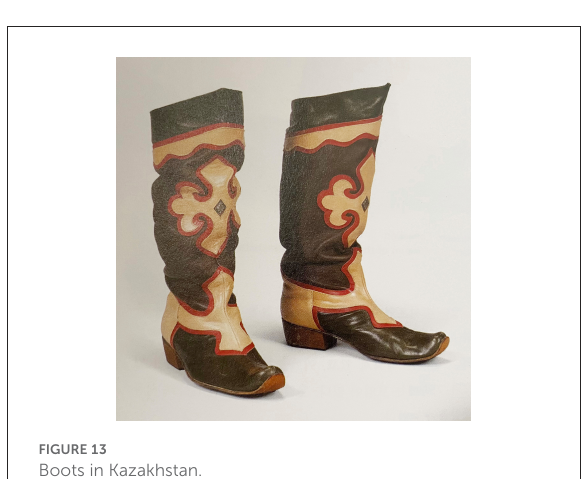
FIGURE13 Boots in